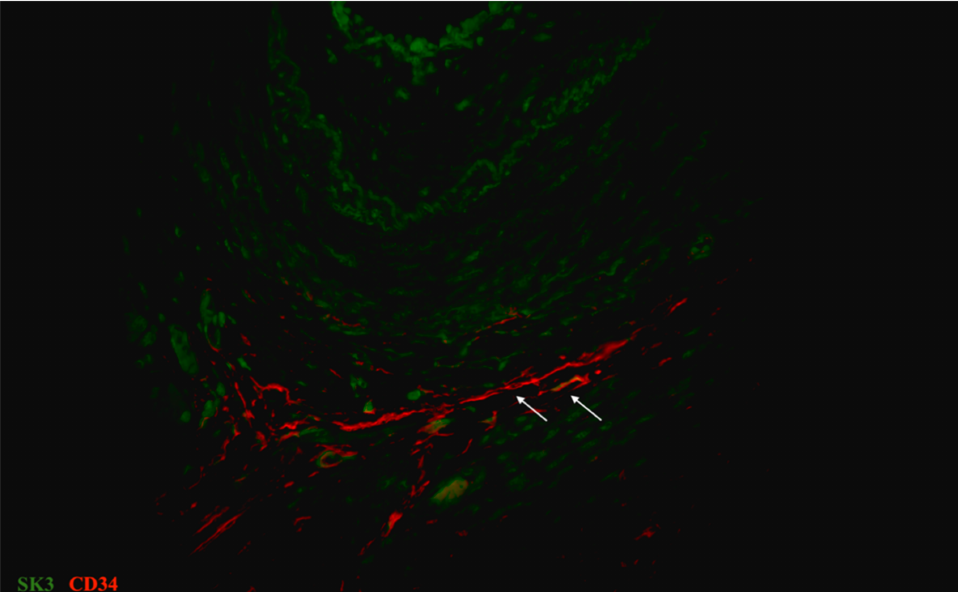
Figure 10. Sample of human oviduct stained for CD34 (red, Alexa Fluor 594) and small-conductance calcium-activated potassium channels isoform 3 (SK3) (green, Alexa Fluor 488). The cell immunopos- itive for CD34 and SK3 was identified as tubal telocyte (has shown by arrows). This doubly im- munopositive cell was observed in the muscular layer. Total magnification: ×